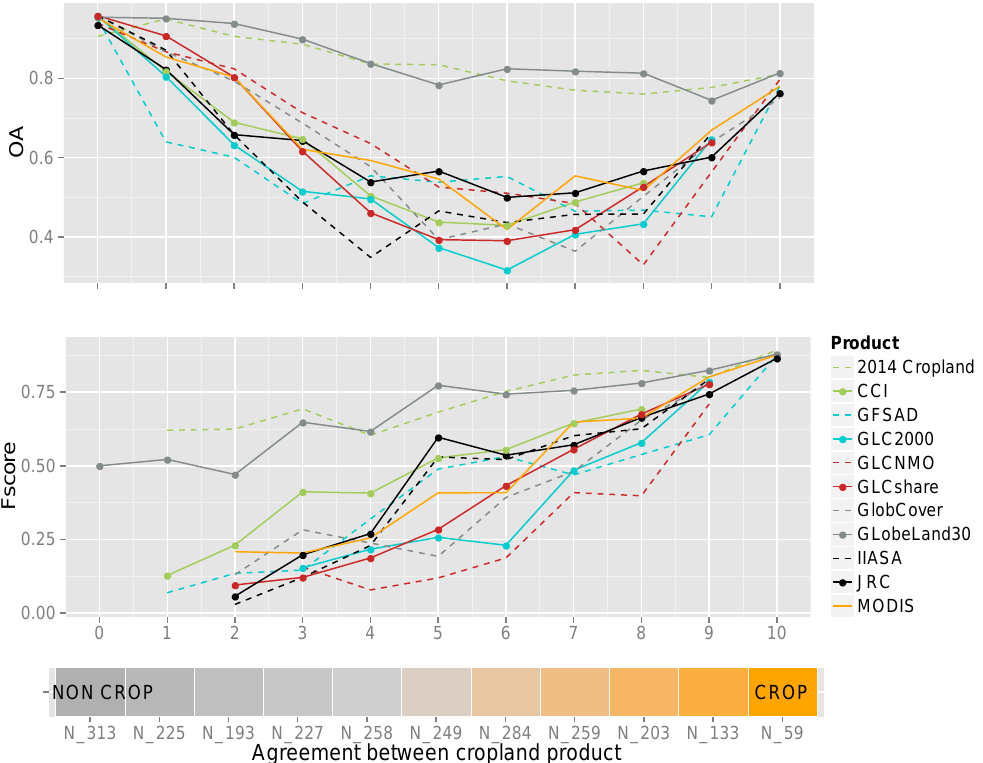
Figure 17. Evolution of OA and F-score with agreement computed on ten global products. The X axis corresponds to agreement between global products with 0 = all products classify pixels as non-crop and 10 = all products classify pixels as crop; N corresponds to the number of validation points corresponding to a given class of